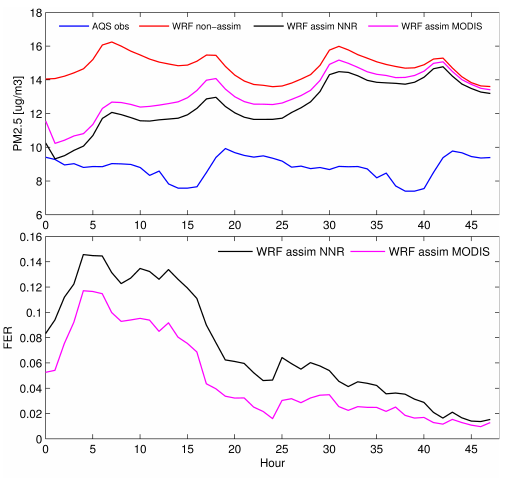
Fig. 8. Mean PM 2 . 5 concentrations (top) and fractional error reduc- tions (FER, bottom) as a function of forecast hour for all AQS sta- tions during the first 10 days of May 2010. All 48h forecasts used to build the mean and FER start at 21 UTC.